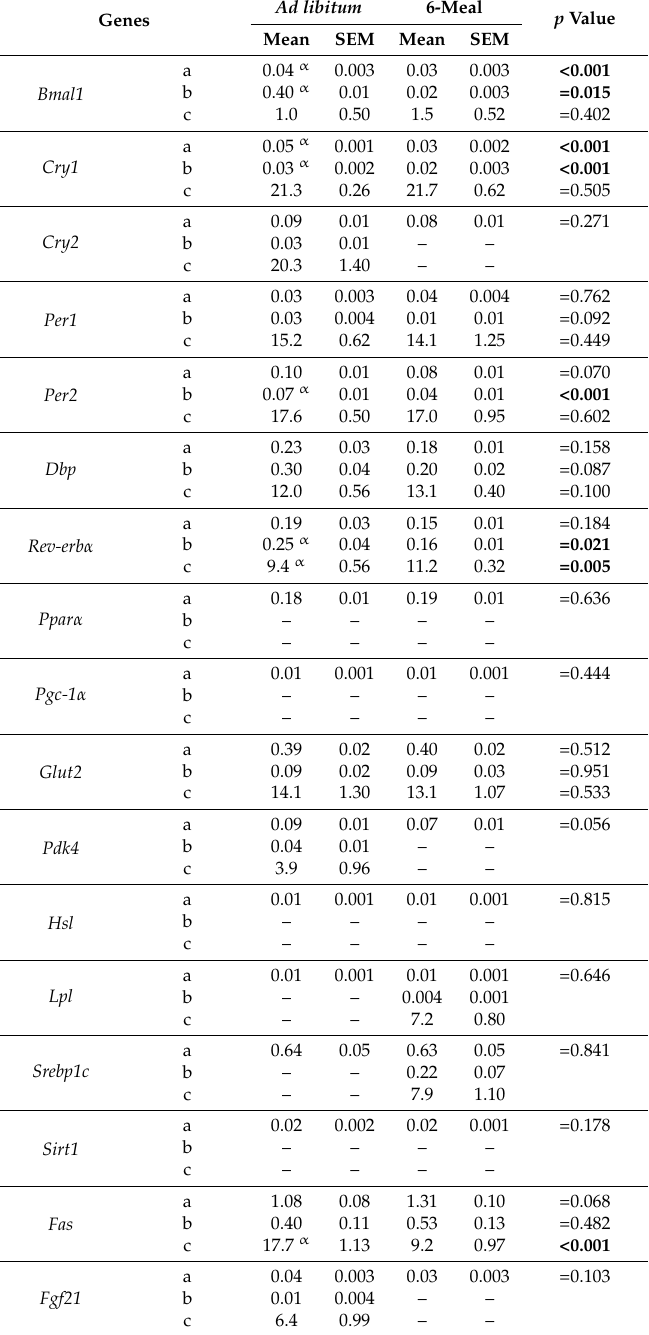
Table 4. t -test analysis on cosinor parameters for clock and metabolic genes in the